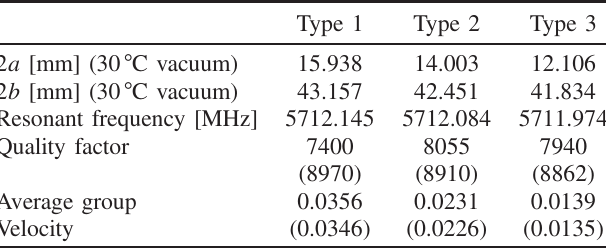
TABLE II. Measured results of the nine-cell test cavities. The designed values are stated in